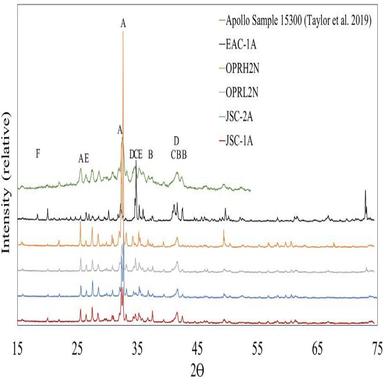
XRD patterns for the five lunar regolith simulants and the pattern for the Apollo 15 sample 15,300 (legend order from top to bottom matches pattern order). The peak labeling corresponds to A) Plagioclase, B) Forsterite, C) Diopside, D) Augite, E) Nepheline, and F) Analcime in this work and not for the Apollo Sample 15,300 pattern.